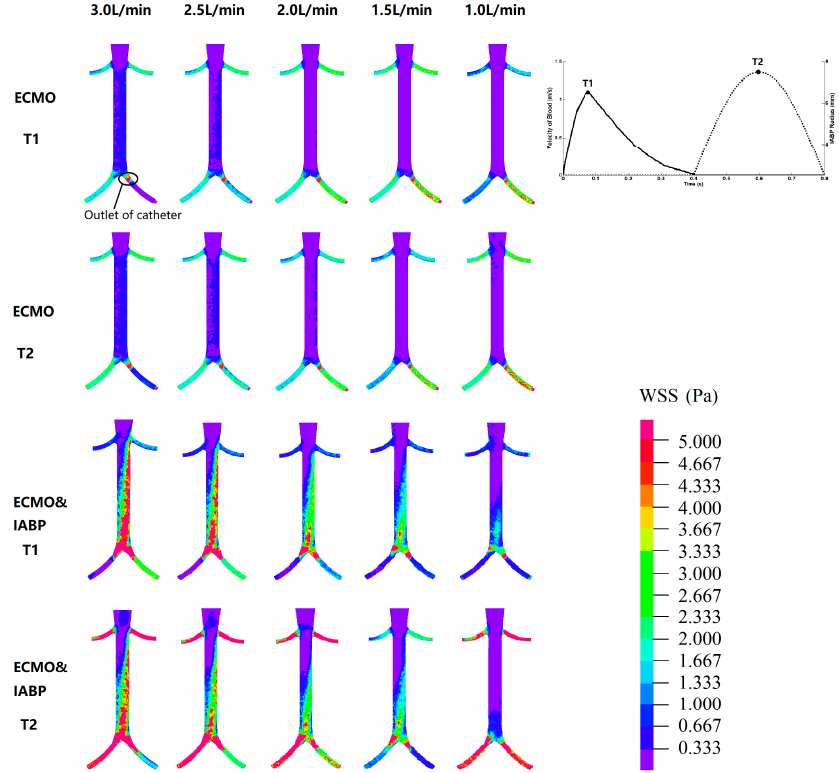
Figure 7. The WSS distribution. T1 is the maximum value of blood velocity at the systole period; T2 is the maximum volume of IABP at the diastole